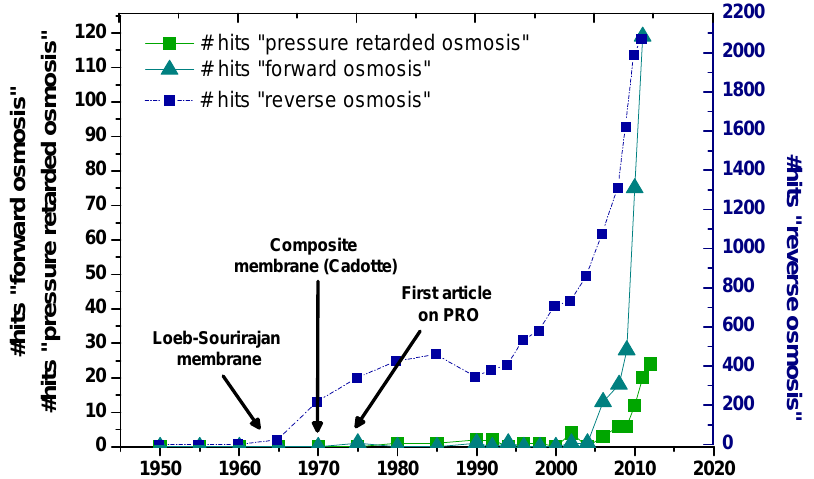
Figure 1. The number (#) of publications on pressure retarded osmosis, forward osmosis and reverse osmosis from 1950 until 2012